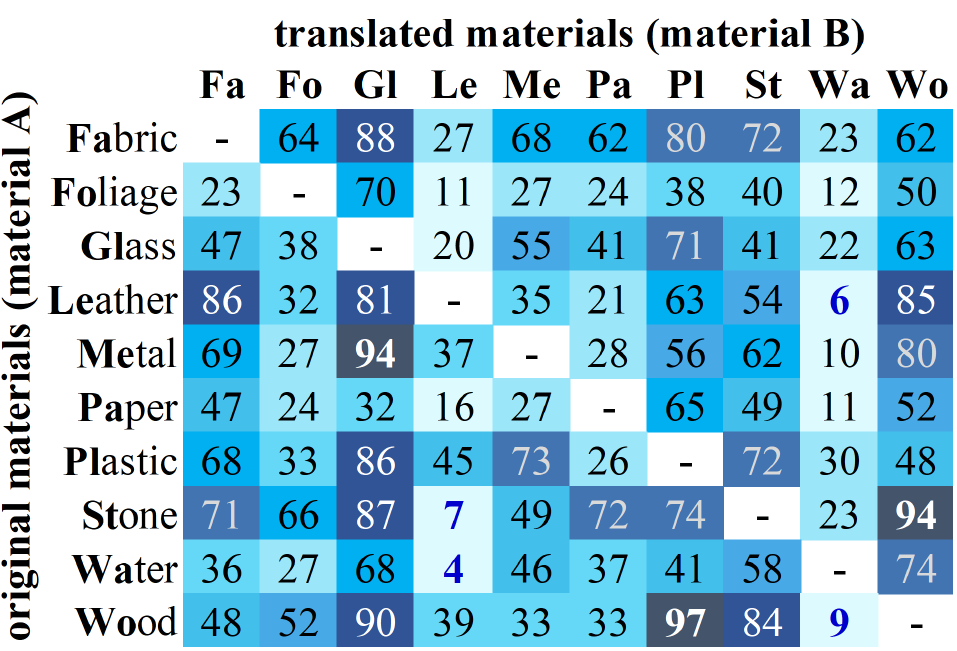
Figure 7. Classification accuracy per material class using our proposed VGG19-IN.